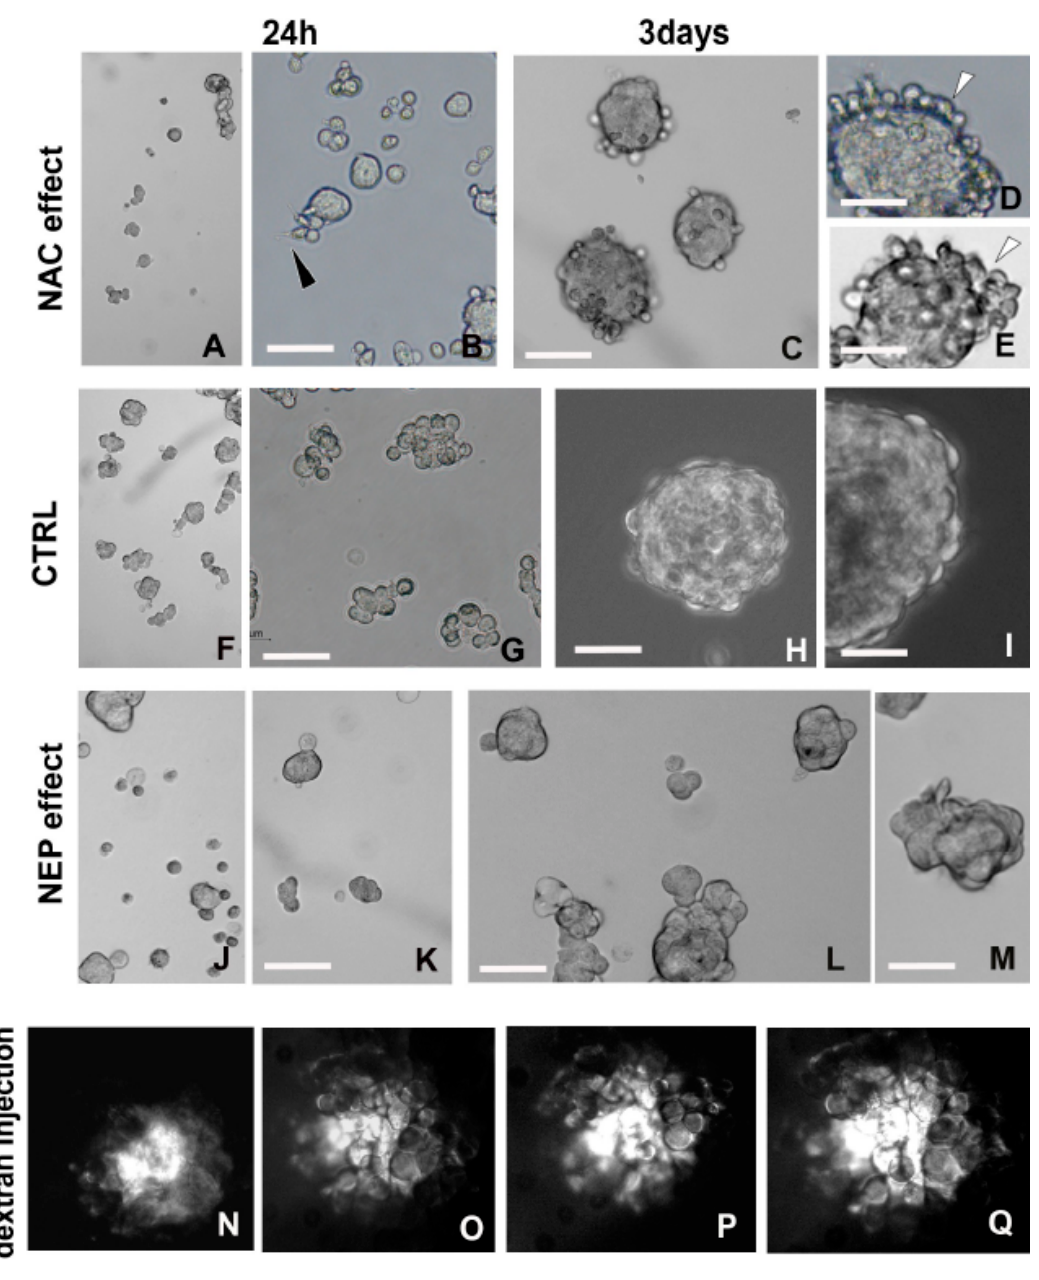
Figure 8. Functional analysis. ( A – I ) Comparison between MCF7 cells after 24 h and 3 days with ( A – E ) and without ( F , I ) NAC treatment. The antioxidant action of this molecule, acting on amyloidogenesis, reduces the MCF7 ability to form spheroids, whose size was smaller and variable in size compared with controls already at 24 h post treatment. ( G – I ). Cells of early aggregates ( B ) are small in size and show protruding thin expansion (arrowhead). Scale bars: ( B ) 45 μ m; ( C ) 50 μ m; ( D , E ) 30 μ m; ( G ) 38 μ m; ( H ) 45 μ m; ( I ) 24 μ m. ( F – M ) Comparison between MCF7 cells after 24 h and 3 days without ( F – I ) or with NEP treatment ( J – M ). From 24 h up to 3 days, the enzymatic degradation by